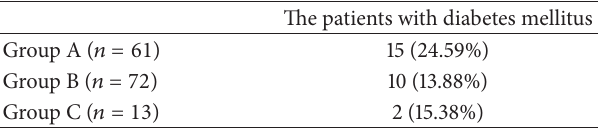
Table 3: The distribution of patients with diabetes